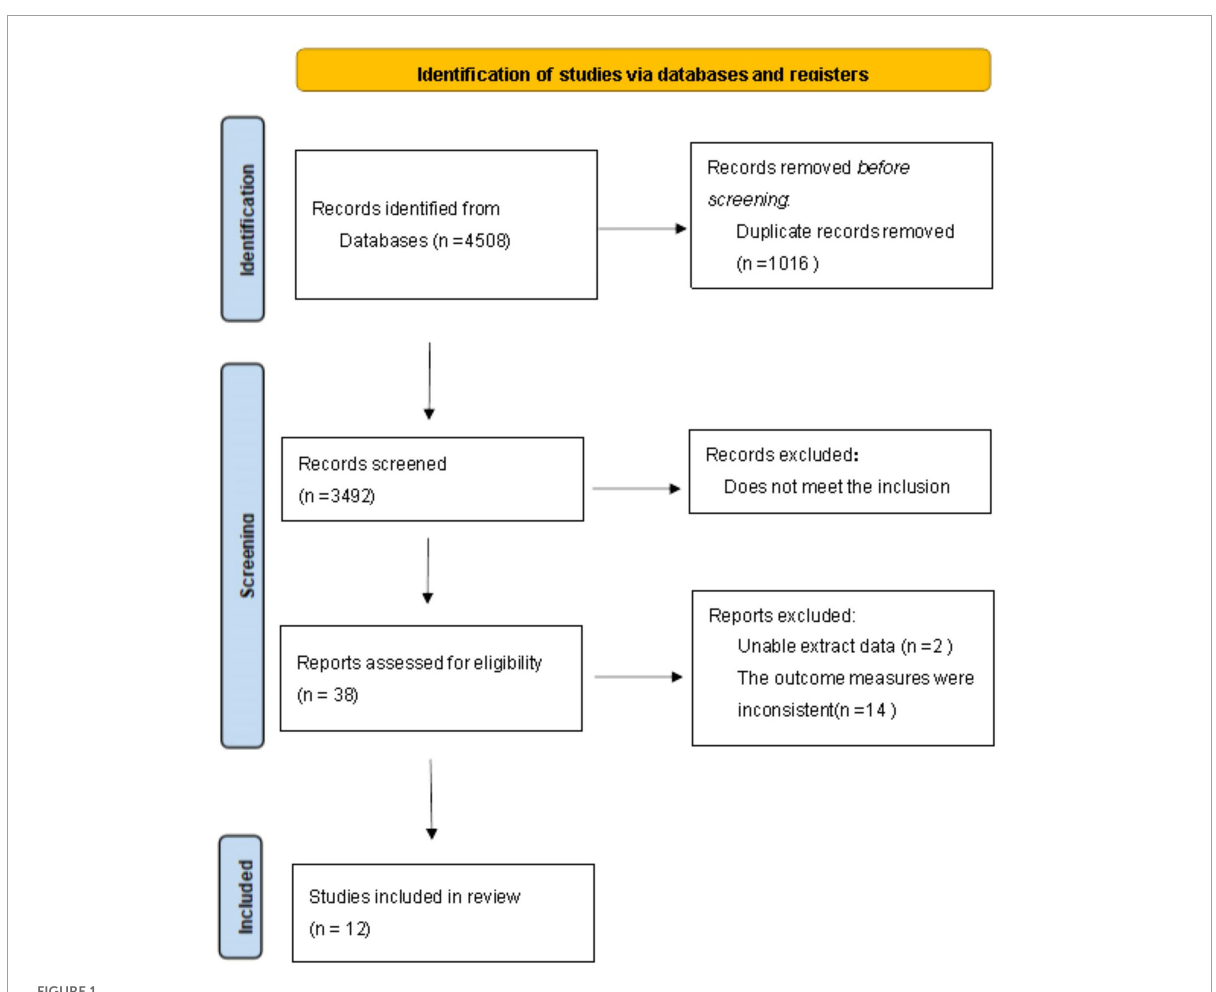
FIGURE1 Flow chart of literature